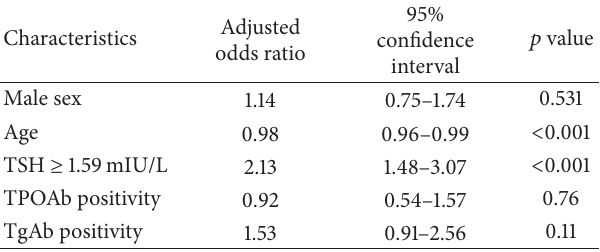
Table 3: Independent risk factors for the diagnosis of thyroid cancer defined by multivariable logistic regression